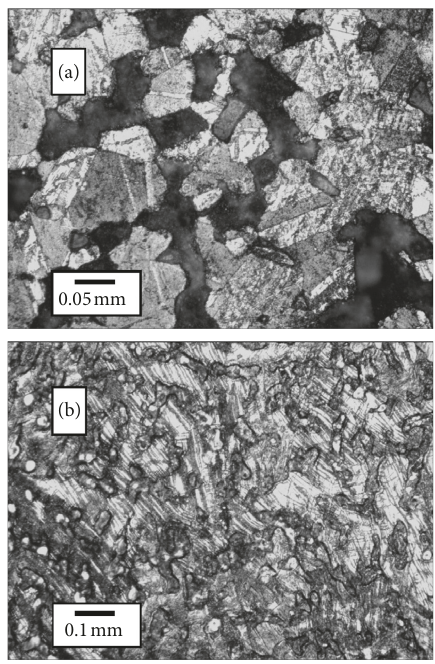
Figure 7: (a) Metallographic images for JW-4, with dark lead containing regions and small, rounded crystals of bronze with banding from annealing, and (b) for AJ-3 with crystal fractures and microstrain as well as bending from a cold strike below the annealing temperature similar to that found in VG-3 and